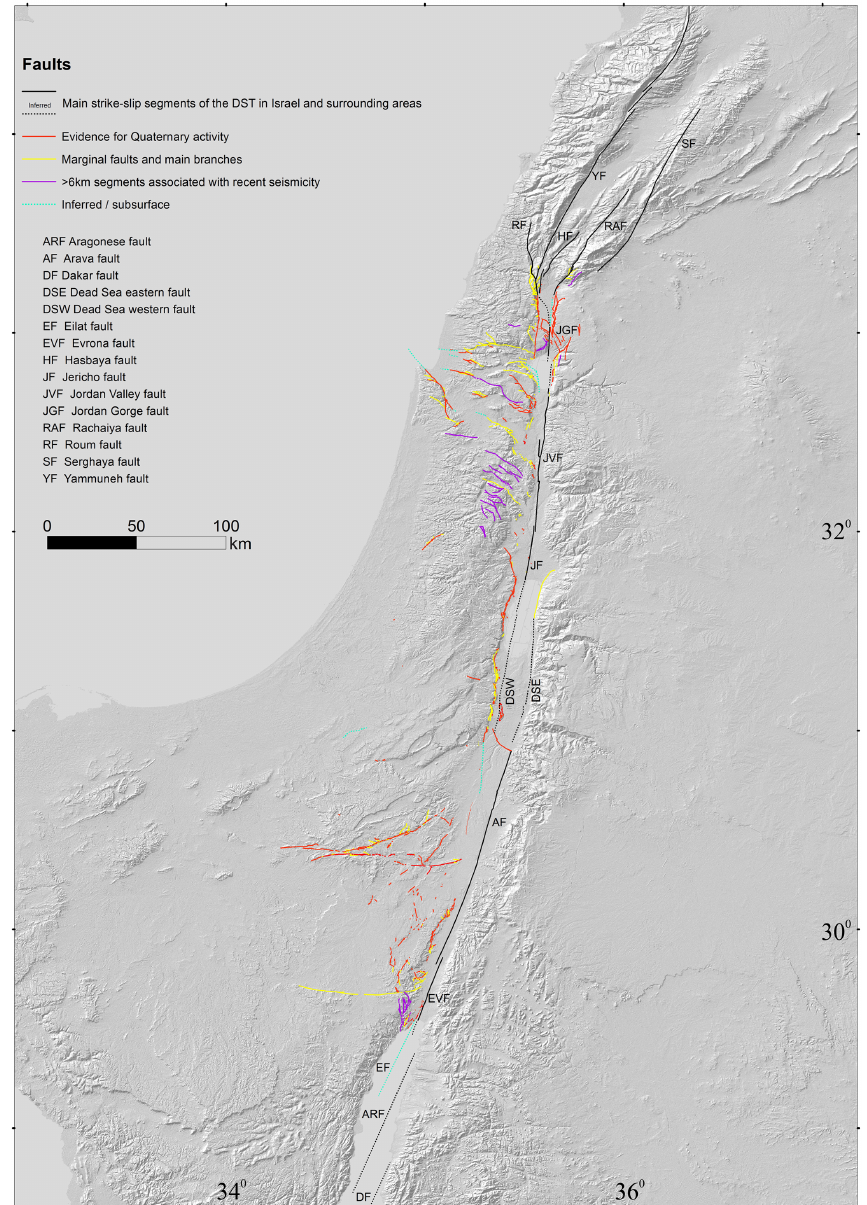
Figure 7. Quaternary fault map of Israel. Colours indicate the corresponding criterion for each fault. Inferred subsurface faults are marked by dashed lines. Abbreviations are for the main strike-slip segments of the